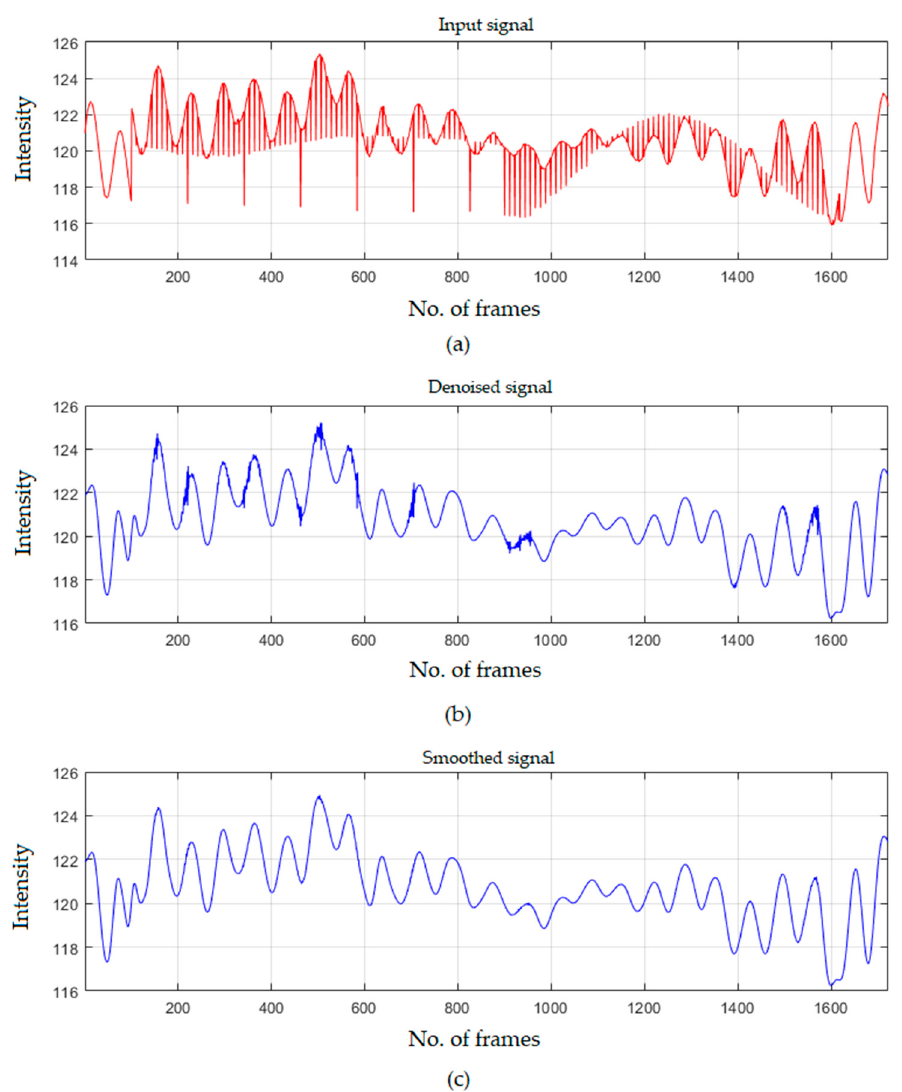
Figure 5. Wavelet signal denoising method ( a ) input signal I Y (cid:4666)𝑡(cid:4667) , ( b ) denoised signal using wavelet = wdenoise( I Y , 4,’Wavelet’,’db20’,’DenoisingMethod’,’UniversalThreshold’,’ThresholdRule’,’Soft’,’NoiseEstimate’,’LevelDependent’), and ( c ) smoothed signal based on a moving average filter with span equal to 5.